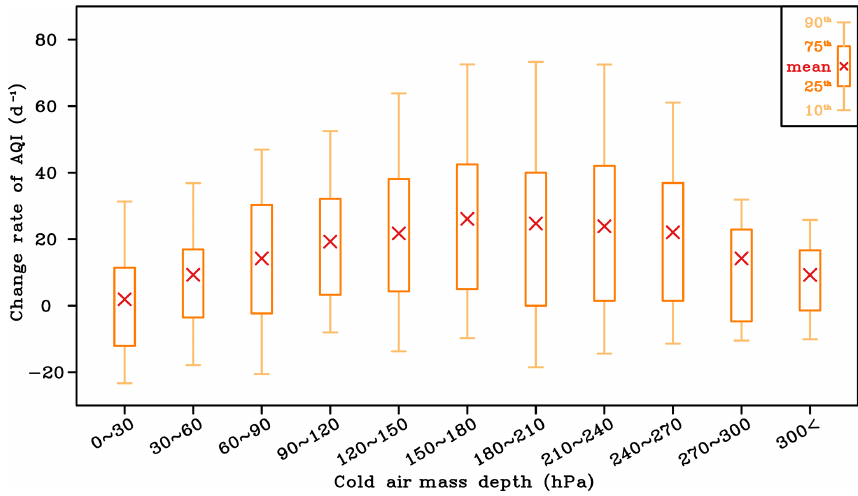
Figure 9. Distribution of the change rate of the AQI with the cold air mass depth during the period after the CAO.